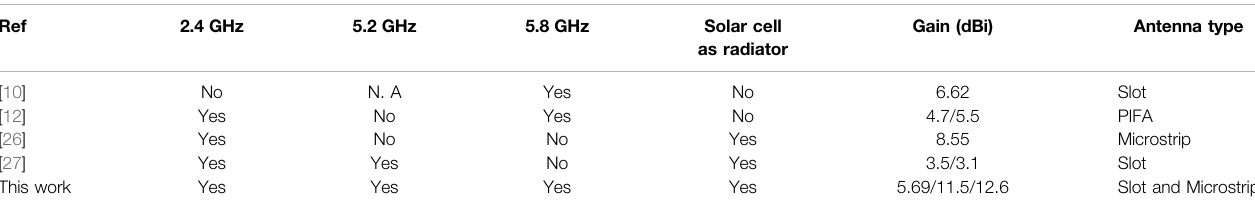
TABLE 2 | Comparison of the proposed antenna with existing designs. Ref